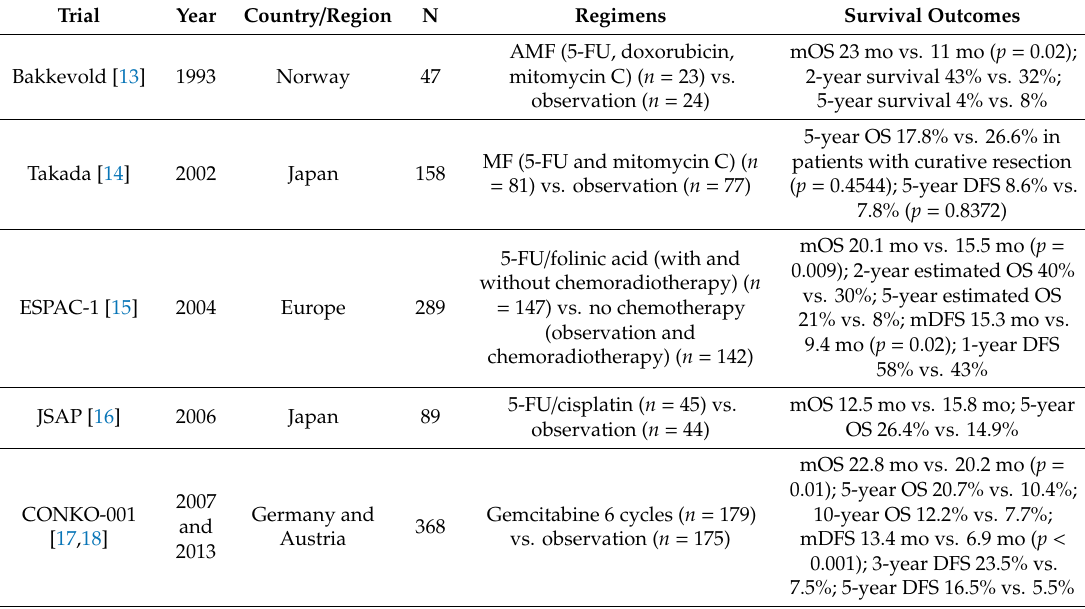
Table 1. Summary of randomized controlled trials concerning adjuvant chemotherapy in patients with pancreatic